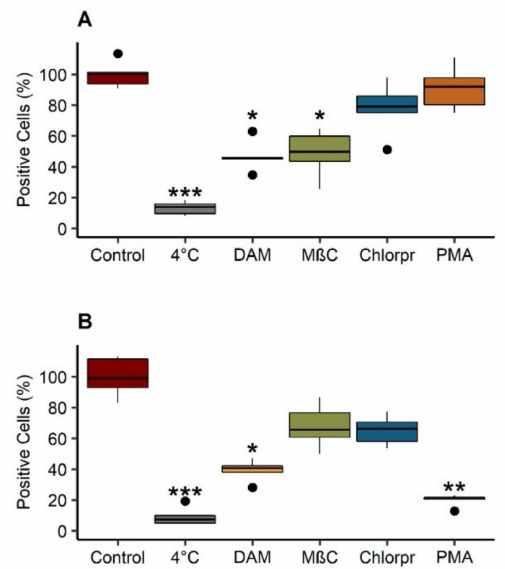
Figure 7. Internalization pathways of pH-sensitive LNC in B16F10 ( A ) and SK-Mel 28 ( B ) at pH 6. Cells were pretreated for 30 min with 1 mmol/L 5-( N , N -dimethyl)amiloride hydrochloride (DAM), 10 mg/mL methyl- β -cyclodextrin (M β C), 50 µ mol/L chlorpromazine (chlorpr.) and 10 µ g/mL phorbol 12 myristate (PMA). Then, they were incubated with 250 µ g/mL of LNC post inserted by C 18 H 37 -P(NVP 21 -co-Vim 15 ) (“LNC post-P5”), fluorescent LNC for 2 h in pH 6 medium, at 37 ◦ C. Control: untreated with inhibitors. 4 ◦ C: untreated with inhibitors and incubated with fluorescent LNC for 2 h, at 4 ◦ C. The percentage of fluorescent cells was determined comparatively with control. Each box represents 50% of the distribution (interquartile range: 25th percentile–75th percentile). Median is marked as a black line in each box. Extending lines from boxes show minimum and maximum values. Outlier data are plot as black circles. Results ( n = 5) were analyzed with a Kruskal–Wallis test, post hoc Dunn’s, correction Hochberg. *** p < 0.001, ** p < 0.01, * p <